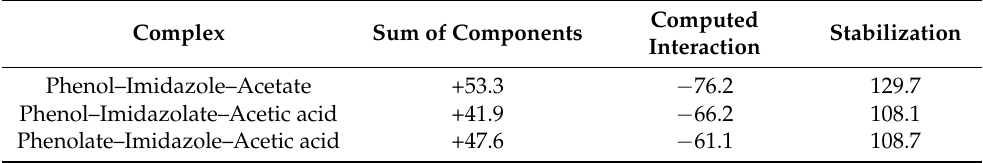
Table 2. Calculated heats of formation (kcal/mol) for quaternary complexes. Complex Sum of Components